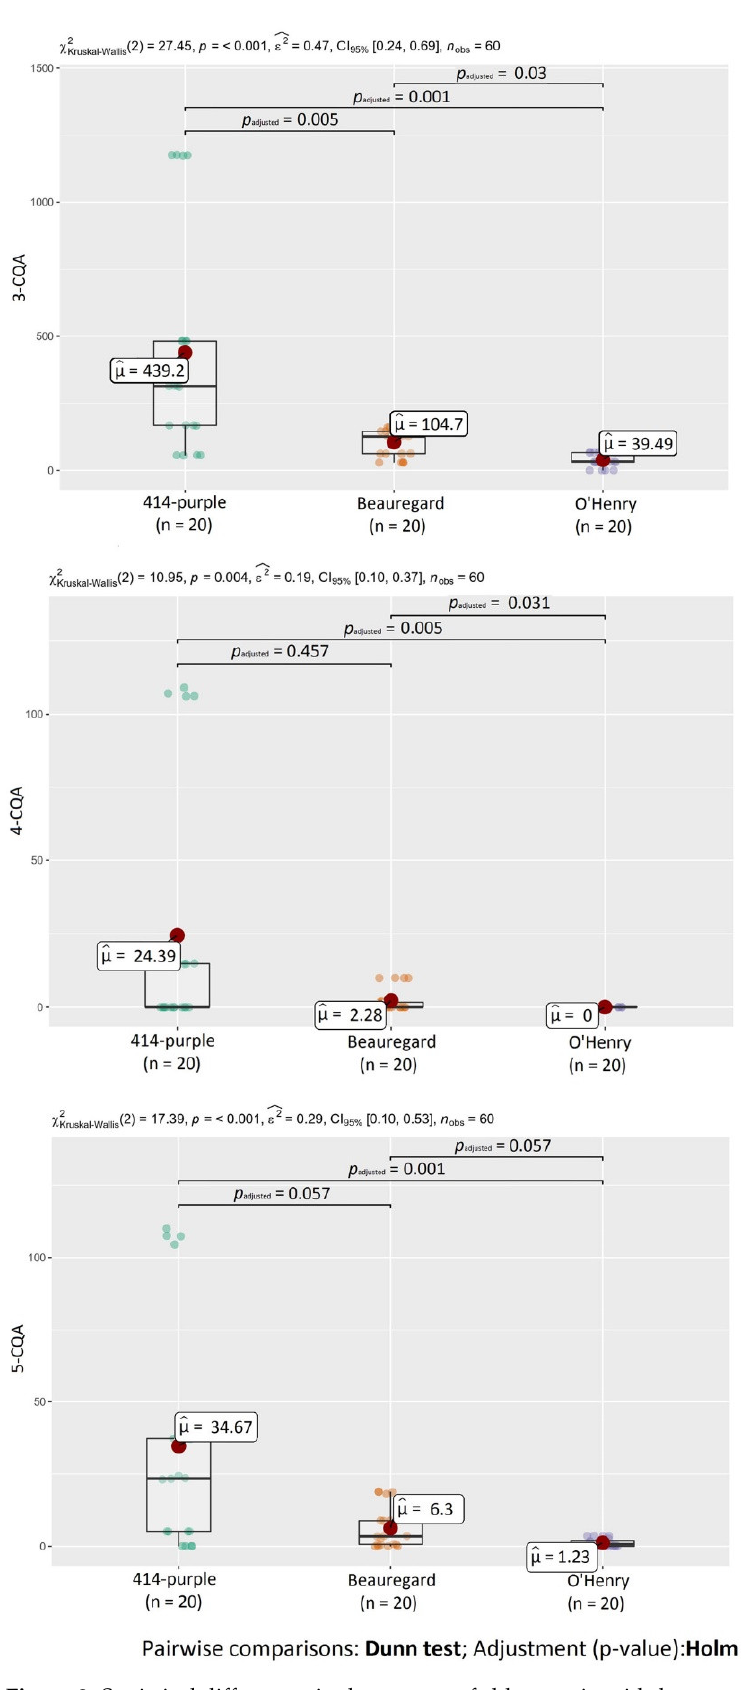
Figure 2. Statistical differences in the content of chlorogenic acids between monitored SP varieties .